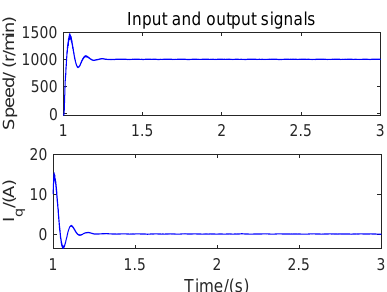
Figure 3. The output and input data of the system to be identified.